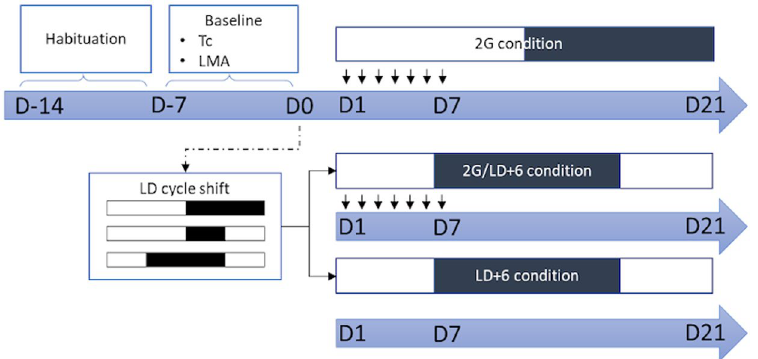
Figure 7. Experimental procedure. Habituation: Seven days where rats lived in their cages, placed in the centrifuge. Baseline: recording Tc and LMA before LD shift. D0: 6 h advance of the LD cycle during the night for 2 G/LD + 6 and LD + 6 conditions only. Each black arrow indicates a 1 h 2 G